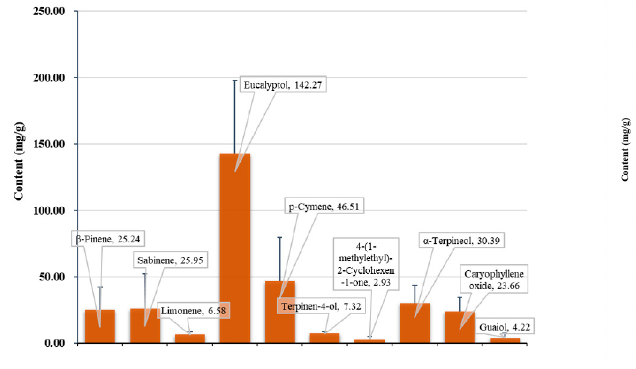
Figure 5. Multivariate statistical analysis of 10 potential effective compounds in 20 batches of Oleum Cinnamomi . Hierarchical cluster analysis dendrogram ( A ). Principal component analysis: score plot ( B ), loading plot ( C ). Orthogonal partial least squares-discriminant analysis (OPLS-DA):